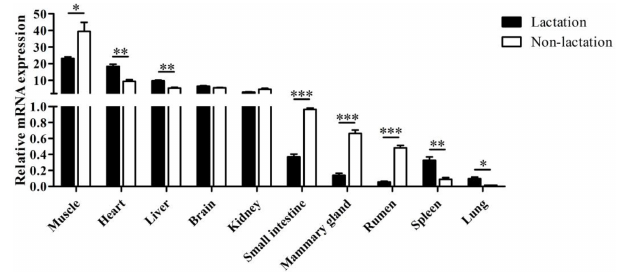
Figure 4. Tissue differential expression of buffalo PPARGC1A in 10 tissues during lactation and non-lactation. The values are pre- sented as means ± SEM; ∗ P < 0 . 05, ∗∗ P < 0 . 01, ∗∗∗ P < 0 .